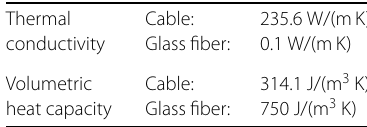
Table 2 Material data of the stack of Rutherford cables